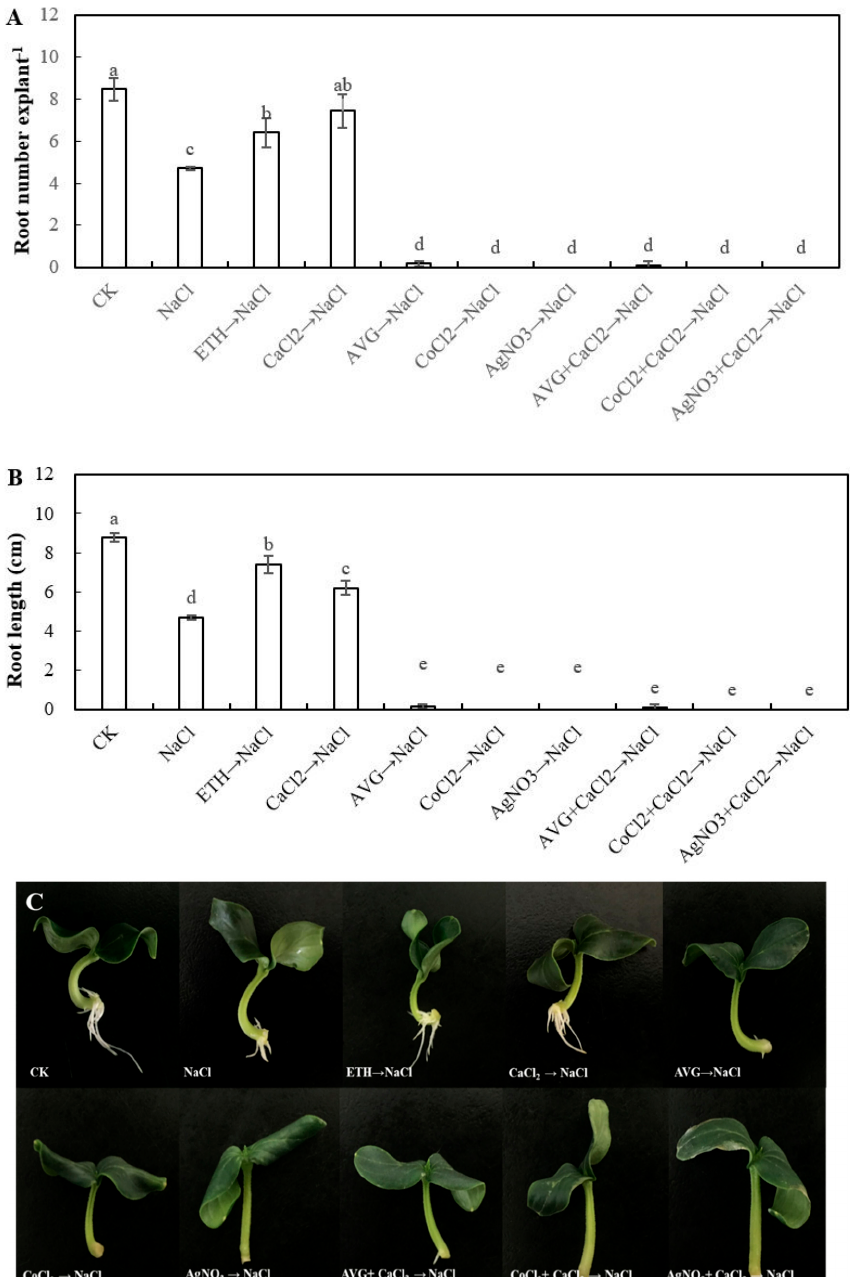
Figure 4. Effects of aminoethoxyvinyl glycine (AVG), cobalt chloride (CoCl 2 ), and sliver nitrate (AgNO 3 ) on adventitious root development in cucumber explants under salt stress. The primary roots were removed from hypocotyl of five-day-old seedlings. Explants were incubated for five days with distilled water as control. Explants were incubated with 13 mM NaCl in three days after being treated with distilled water or 0.1 µ M ethrel, 10 µ M CaCl 2 , 10 µ M AVG, 20 µ M CoCl 2 , 10 µ M AgNO 3 , 10 µ M AVG +10 µ M CaCl 2 , 20 µ M CoCl 2 + 10 µ M CaCl 2 , 10 µ M AgNO 3 +10 µ M CaCl 2 for two days, respectively. The numbers ( A ) and root length ( B ) of adventitious root were expressed as mean ± SE ( n = 3, 10 explants were used per replicate). Bars with different lowercase letters were significantly different by Duncan’s multiple range test ( P < 0.05). Photographs ( C ) show hypocotyl explants after five days of the treatments